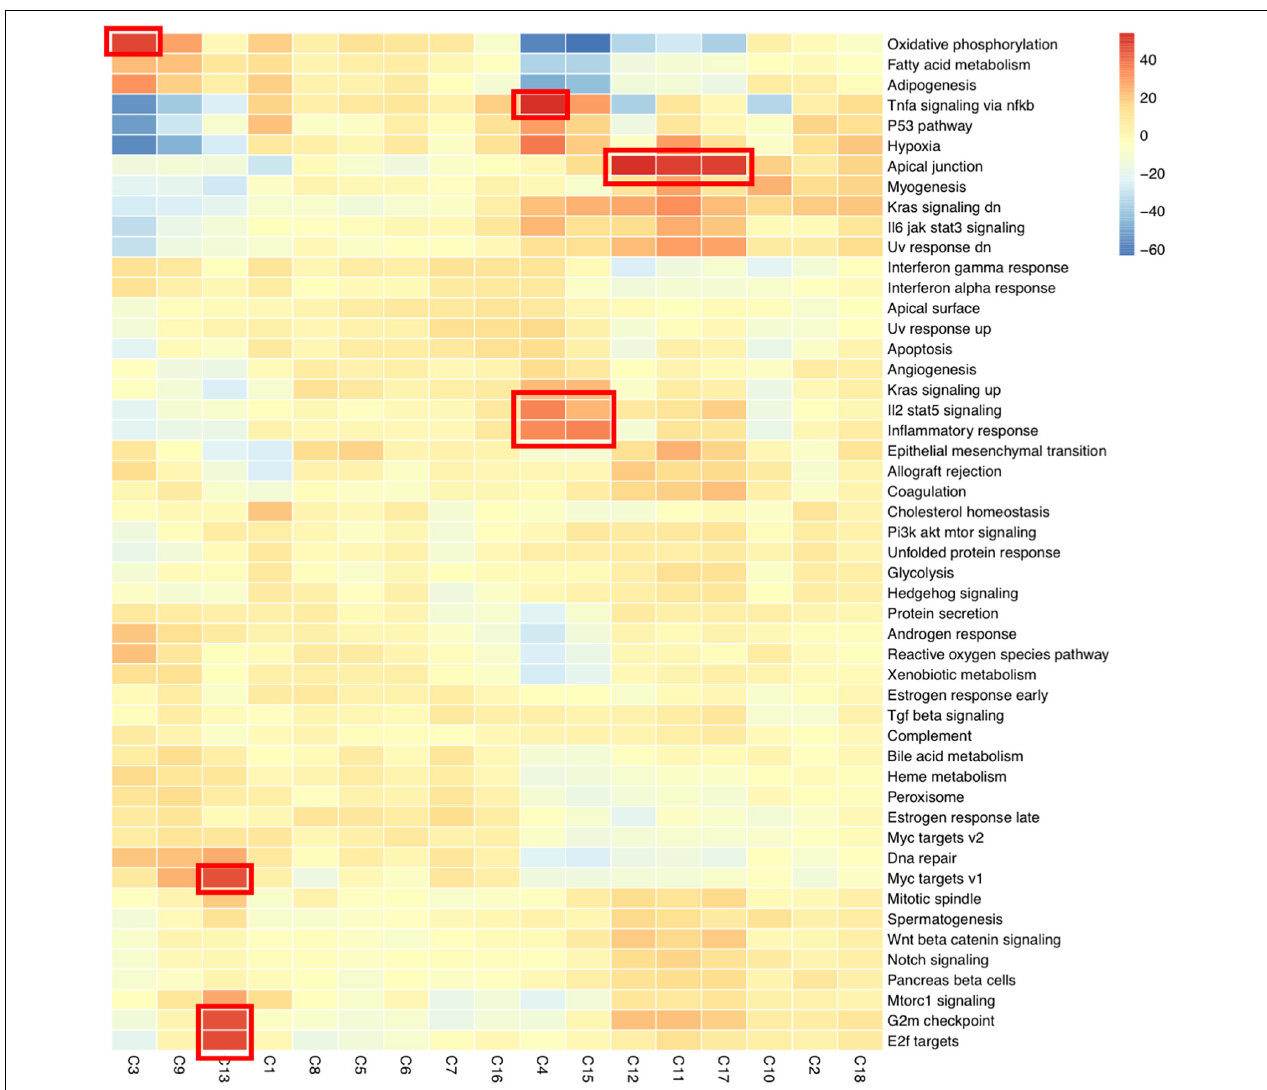
FIGURE 4 | The heatmap showing the average expression of known marker genes related in in each epithelial cluster (cells under chow diet) by Gene Set Variant Analysis (GSVA). Clusters 11, 12, and 17 (cells under chow diet) were enriched in genes related with apical junction. Cluster 13 was enriched in genes of G2m checkpoint, E2f targets, Myc targets V1. Clusters 4 and 15 were enriched in genes involved in inflammatory response, Il2 stat5 signaling, Tnf α singling via Nf κ b. Cluster 3 was enriched in oxidative